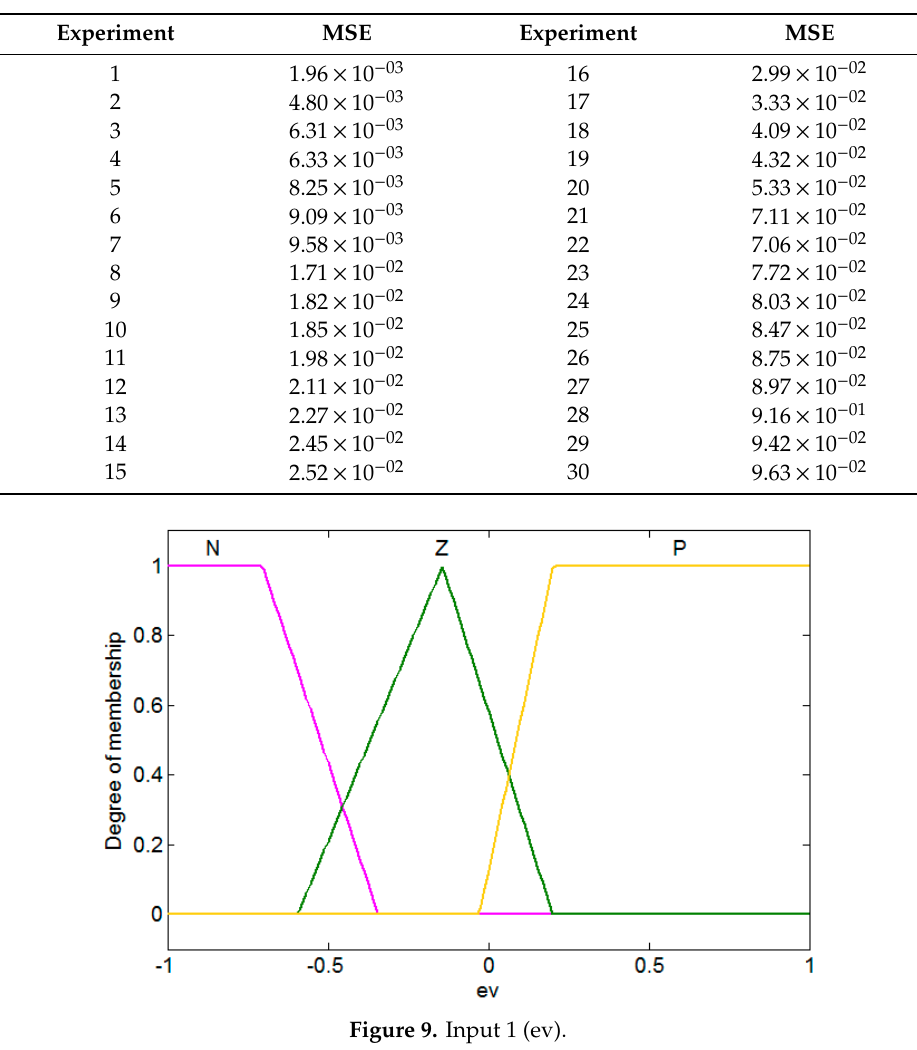
Table 15. Results of the experiments with the fuzzy controller.